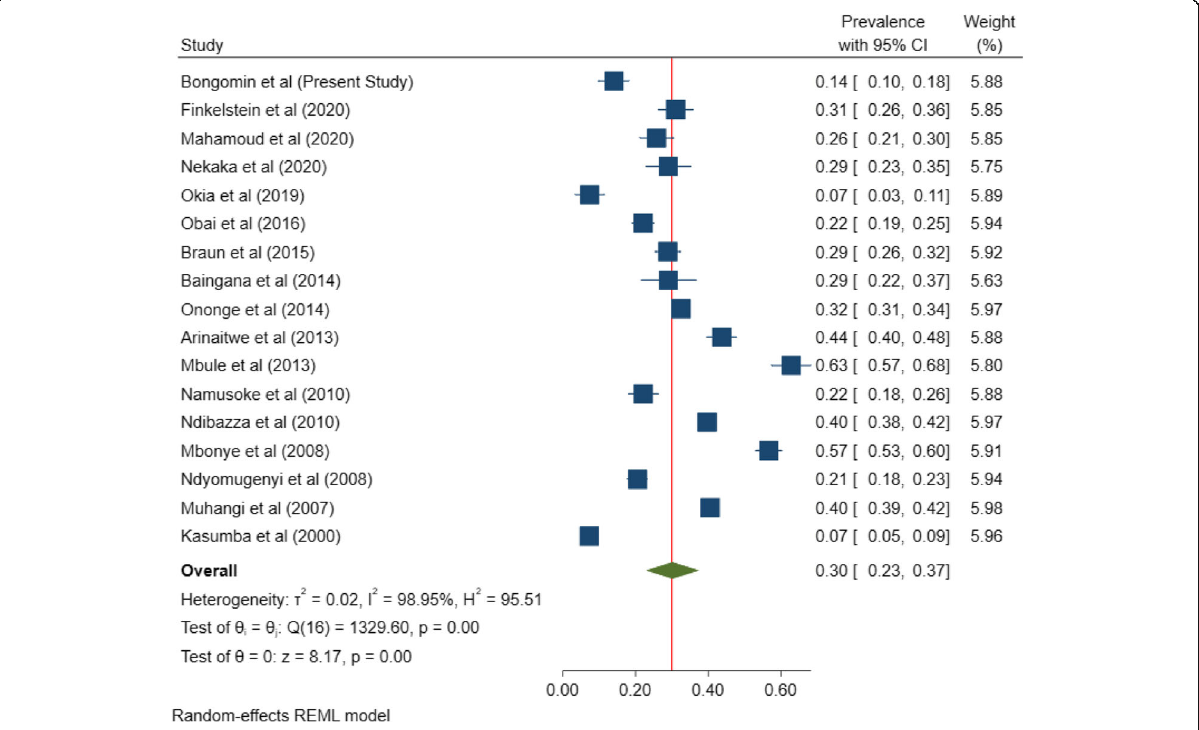
Fig. 2 Pooled prevalence of anemia in pregnancy in Uganda